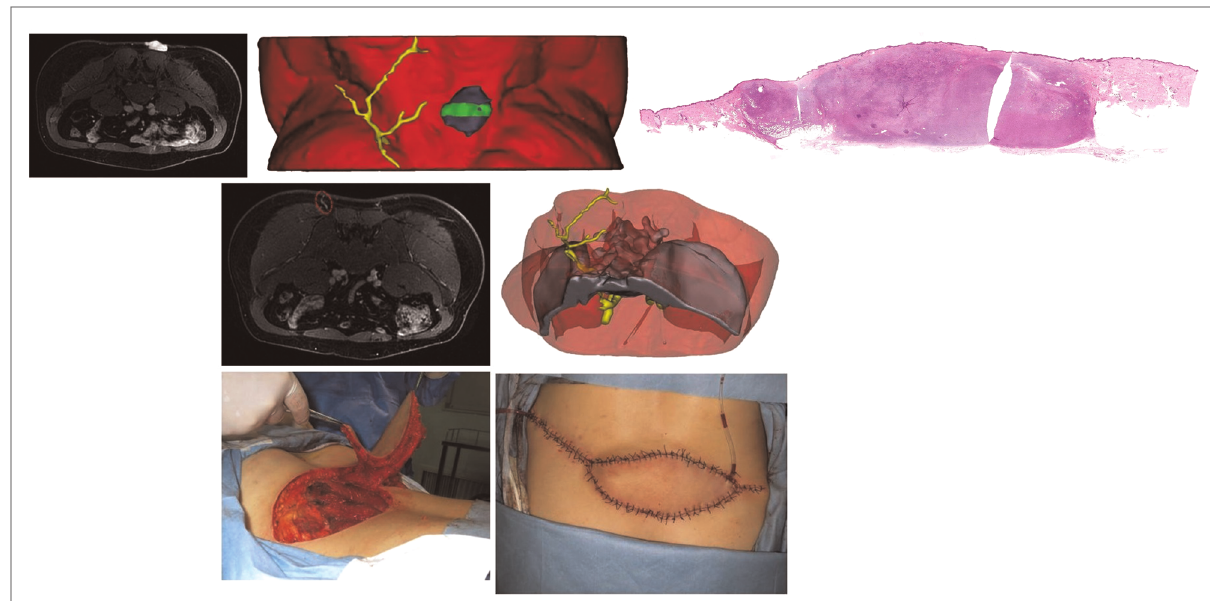
FIGURE 6 (Above, left) preoperative MRI showing the tumor overlying the thoracolumbar fascia. (Above, median) 3DR showing the surgical anatomy involving the tumor, underlying muscle, and perforators. The green area corresponds to the front MRI picture and later pathological imaging. (Above, right) Integrated H&E (hematoxylin and eosin) image from multiple slices showing the pathological morphology of the whole tumor section. (Center, left) preoperative MRI showing the preferred perforator (red dotted ellipse). 3DR showed that the preferable perforator originated from the lateral sacral artery piercing the second anterior and posterior sacral foramens. (Below, median) Harvesting the fl ap. (Below, right) rotation of the fl ap for 160° to cover the wound and direct closure of the donor